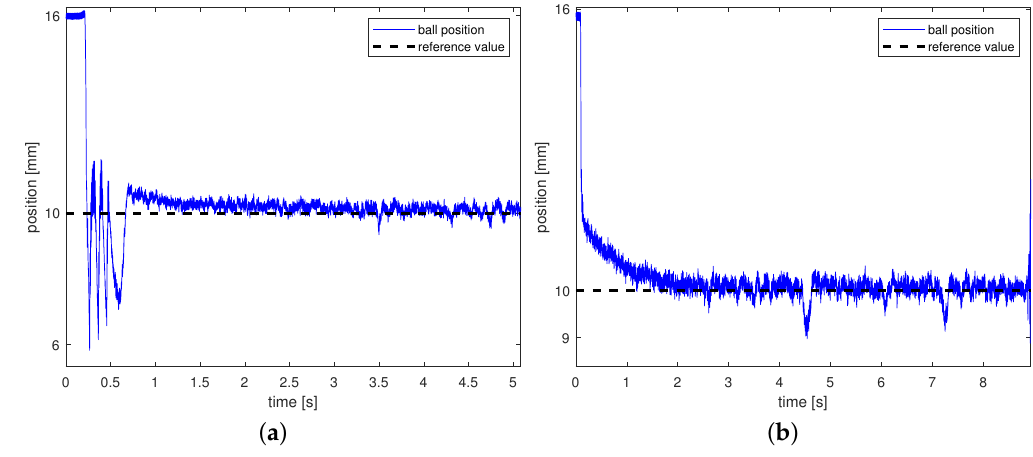
Figure 6. ( a ) Ball position stabilization process with controller tuning by the analytic method, ( b ) ball position stabilization process with controller tuning by the SA method. ( a ) shows the process of stabilizing the position of the ball under the electromagnet with regulator tuning by the analytic method. The regulation time is approx. 1.5 s. The maximum overshoot is approx. 6 mm. When the working point is reached, vibrations are noticeable in its vicinity; ( b ) shows the process of stabilizing the position of the ball under the electromagnet with controller tuning by the SA method. The regulation time is approx. 2 s. There is no overshoot here. When the working point is reached, vibrations are noticeable in its vicinity.